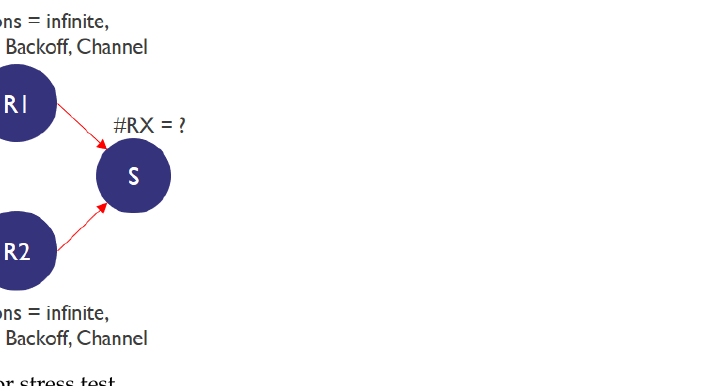
Figure 17. Topology for stress test.